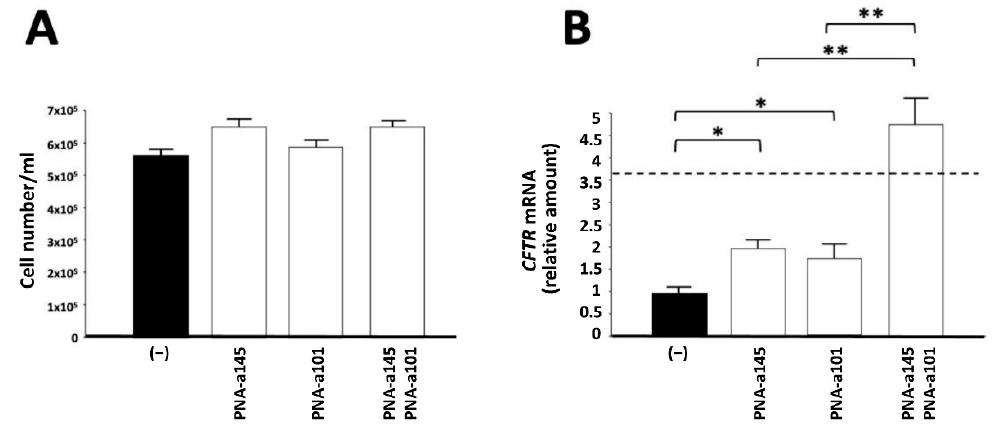
Figure 2. Effects on cell proliferation and CFTR mRNA accumulation of combined treatment of Calu-3 cells with PNAs against miR-145-5p and miR-101-3p. Calu-3 cells were treated for three days with PNA-a145 and PNA-a101, administered either singularly, or in combination. After these treatments, cell number/mL was determined, and CFTR mRNA content was analyzed by RT-qPCR. ( A ) effects on cell growth; ( B ) effects on CFTR mRNA. The results of ( B ) represent the fold change of the CFTR with respect to control untreated Calu-3 cells ( n = 3 independent RT-qPCR experiments; * p < 0.05, ** p < 0.01). The dotted line represents the sum of the values obtained with single administrations of PNA-a145 and PNA-a101.